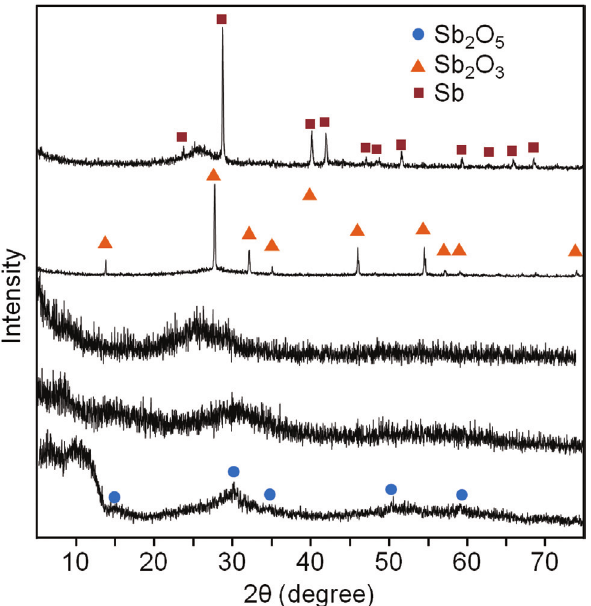
Figure 3: X-ray diffractograms of antimony oxide@GO. From bottom: Antimony oxide@GO at room temperature, after 5 h of heat treatment at 80 ° C, after 0.5 h at 300 ° C, after 2 h of heat treatment at 300 ° C and after 2 h of heat treatment at 650 ° C. The dif- fractions of cubic Sb O , cubic Sb O and trigonal antimony (0) are 2 5 2 3 indicated by circles, triangles and squares, respectively.